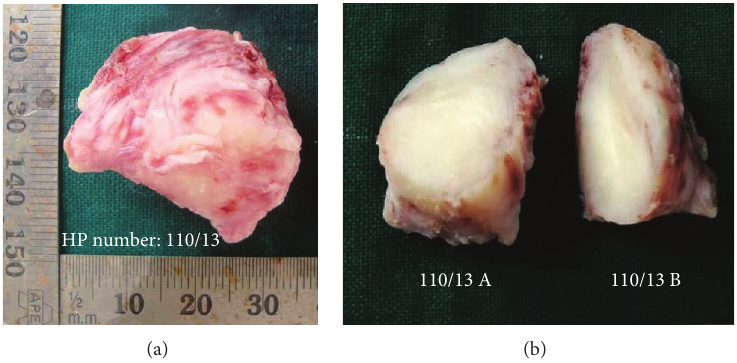
Figure 2: (a) Gross specimen of the excised tumour. (b) Cut surface of the excised tumour.